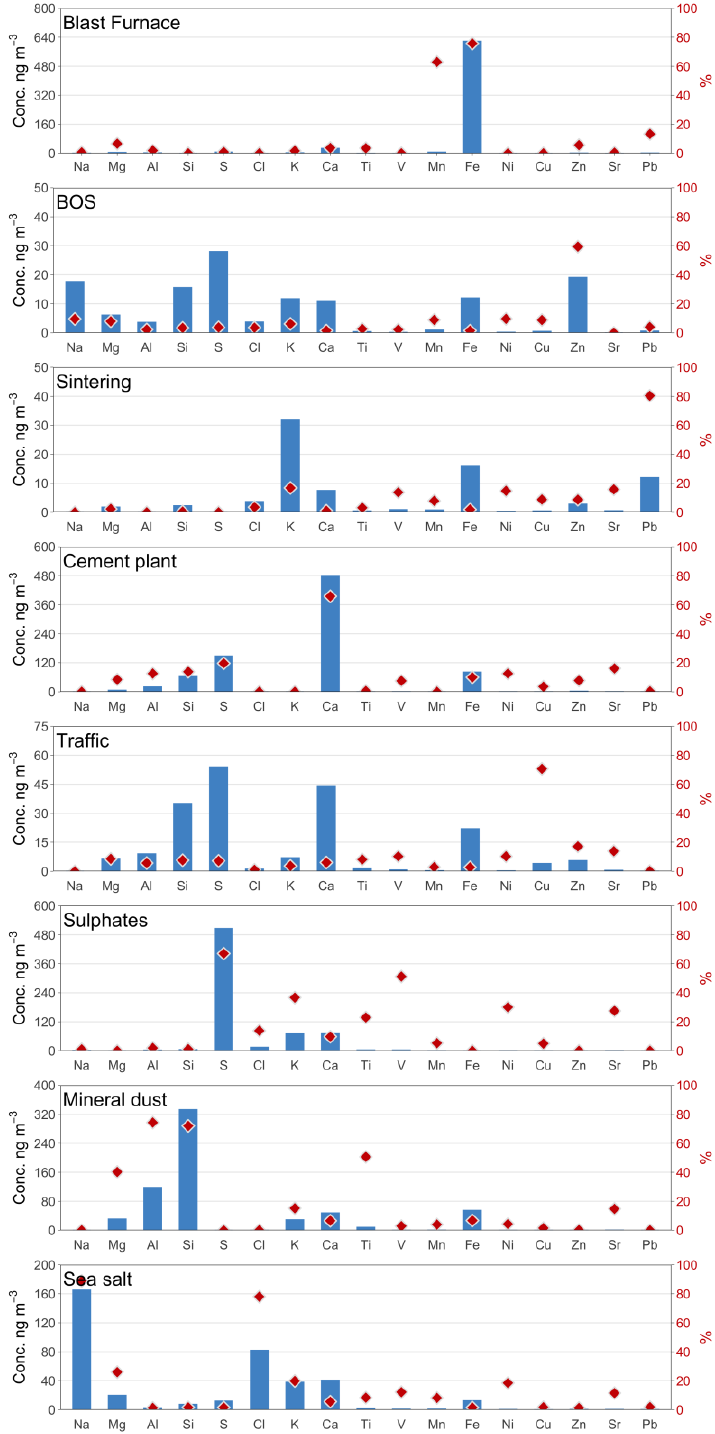
Figure 6. Source profiles obtained by positive matrix factorization (PMF) analysis of the fine fraction dataset: contribution of each species to the chemical profile composition of each source (ng/m 3 , blue bars) and average percentage contribution of each source to the concentration of each element (%, red diamonds).